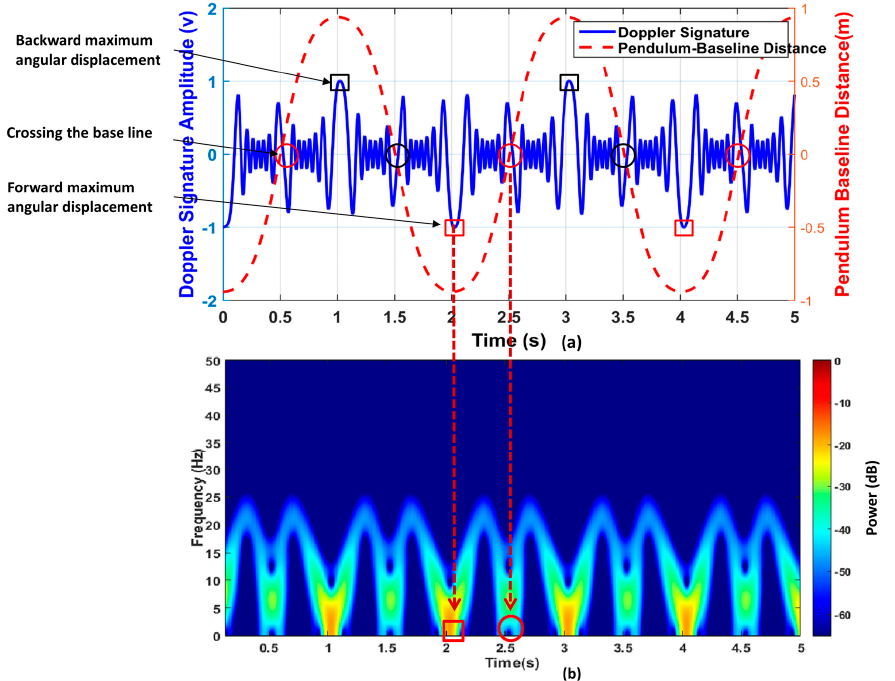
Figure 2. Simulation results of Doppler signature created from one pendulum swinging on the baseline with fixed pivot and initial angular displacement θ 0 = 70 ° : ( a ) time domain Doppler signature in comparison with the pendulum position relative to the baseline; and ( b ) spectrogram of Doppler signature.